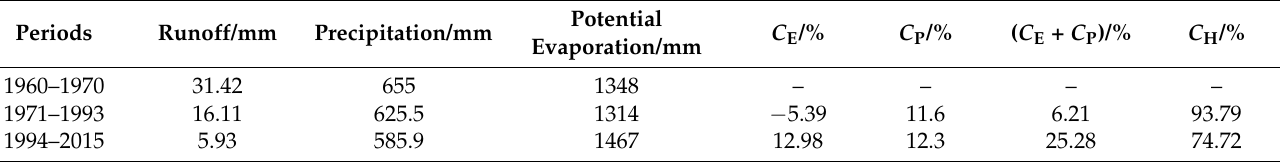
Table 8. The contribution rate of climate change and human activities to runoff